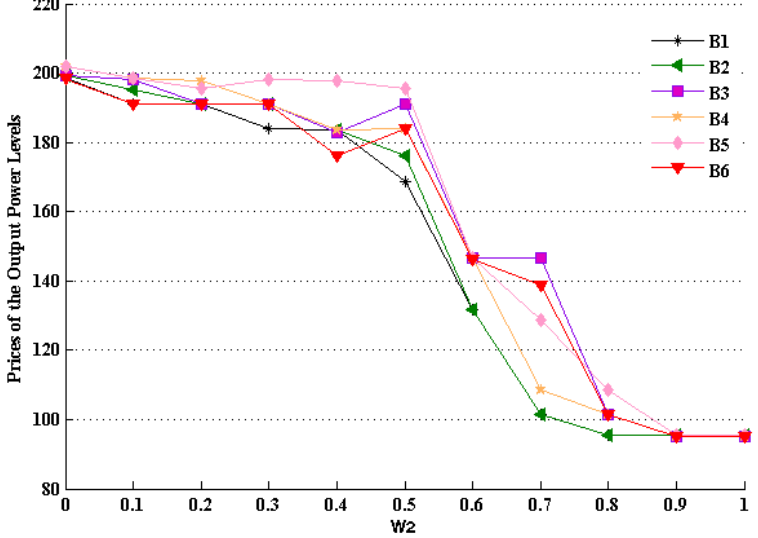
Figure 4. The trend of B n s with respect to the weighting factors.